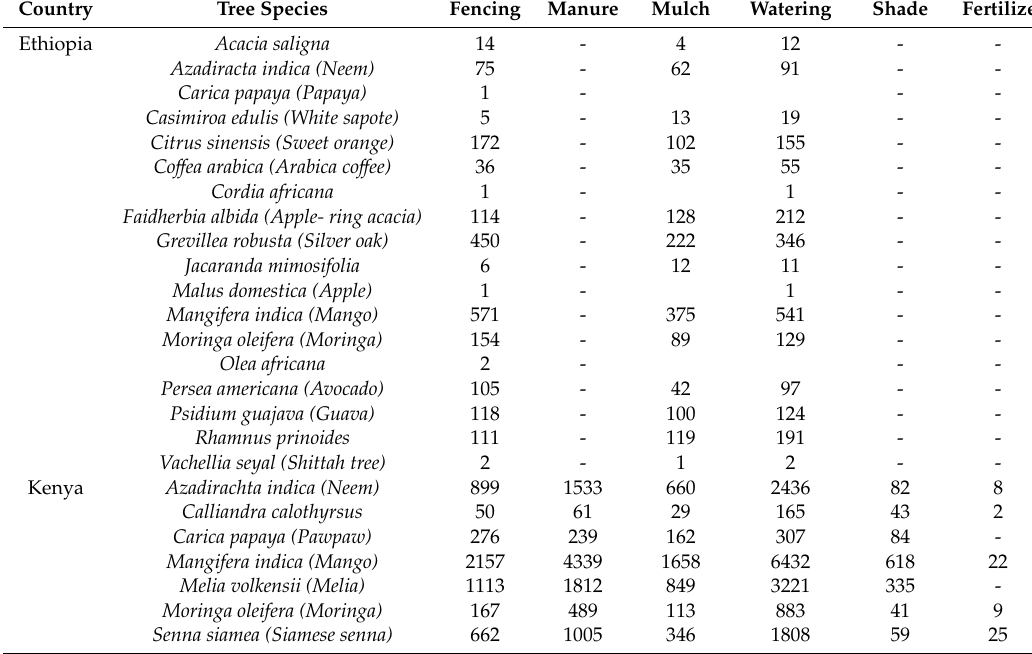
Table 2. Number of tree seedlings under each option in Kenya and Ethiopia. Where available, a common name for each species is added in the